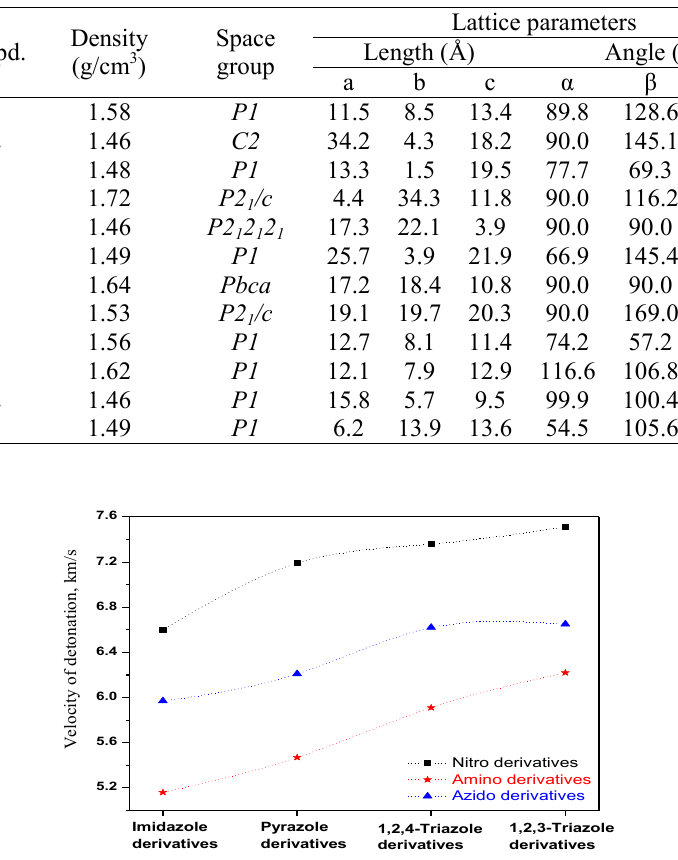
Figure 4. The profile of velocity of detonation (km/s) of the triazine